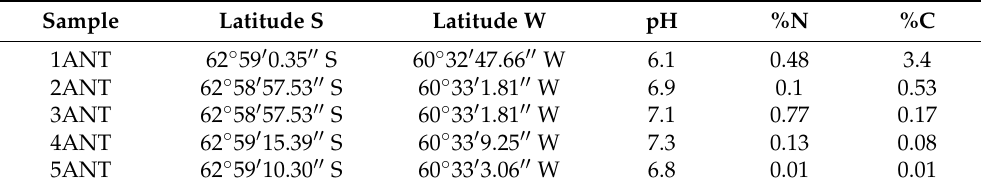
Table 1. Coordinates and environmental parameters determination for soil